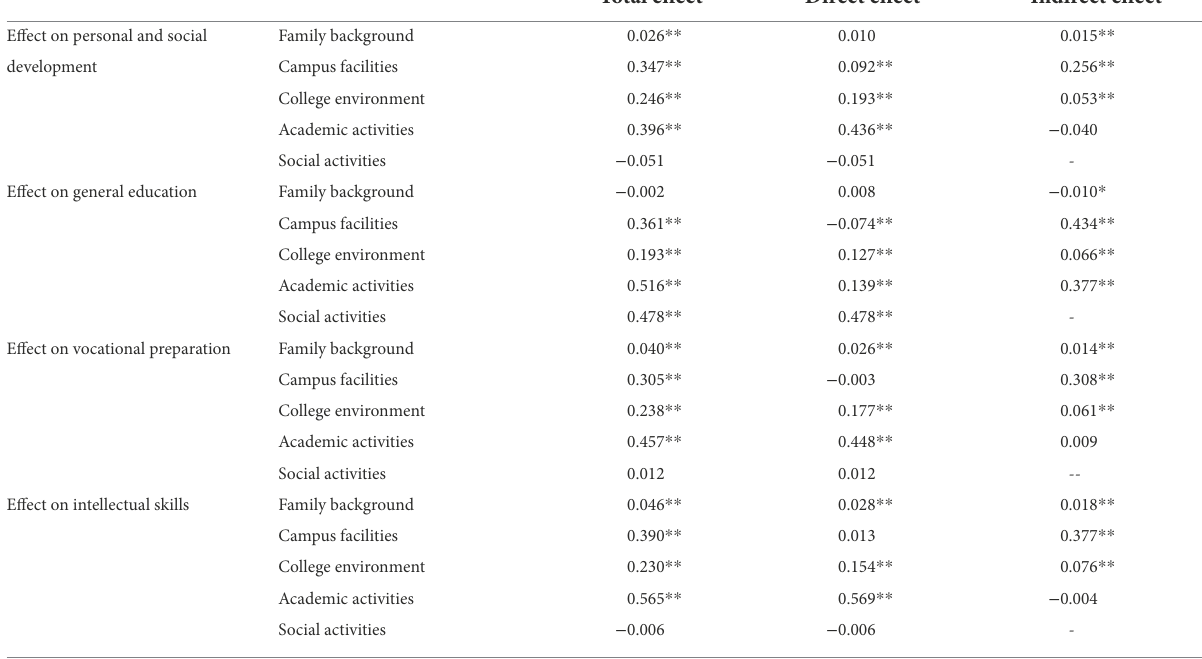
TABLE 3 Effects on the four dimensions of student learning